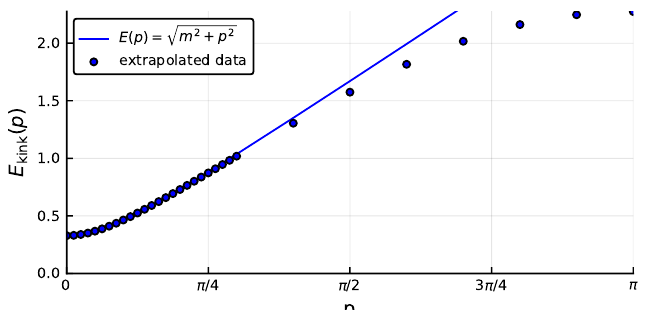
Figure 4 . The kink energy as a function of the momentum on the blocked lattice for g = 1 . 4 , as compared to the corresponding Einstein energy-momentum relation, indicating Lorentz invariance over a relatively large range of